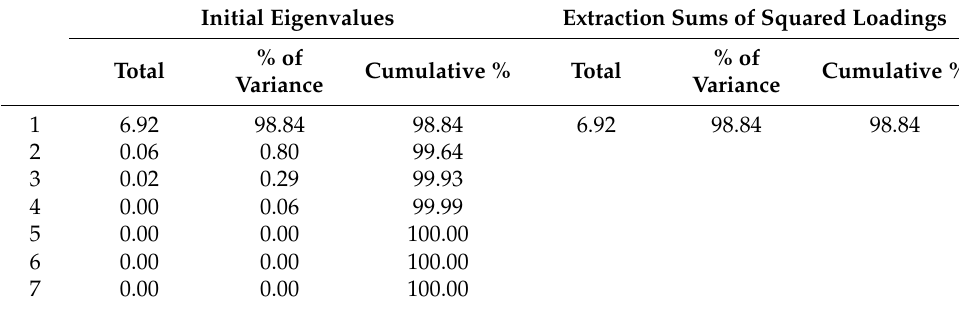
Table 4. Results of the principal component analysis of pollutant